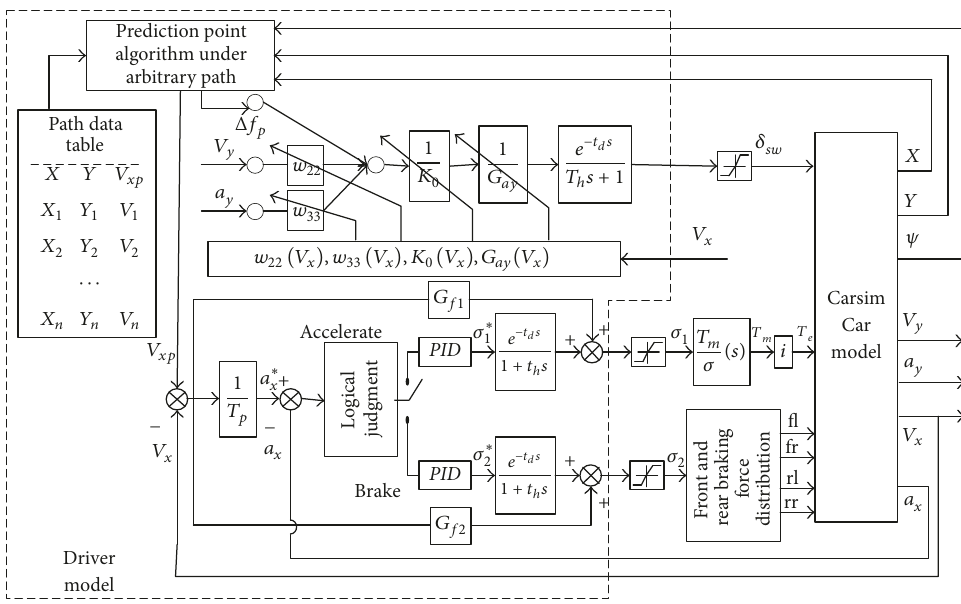
Figure 16: Direction and longitudinal speed integrated control